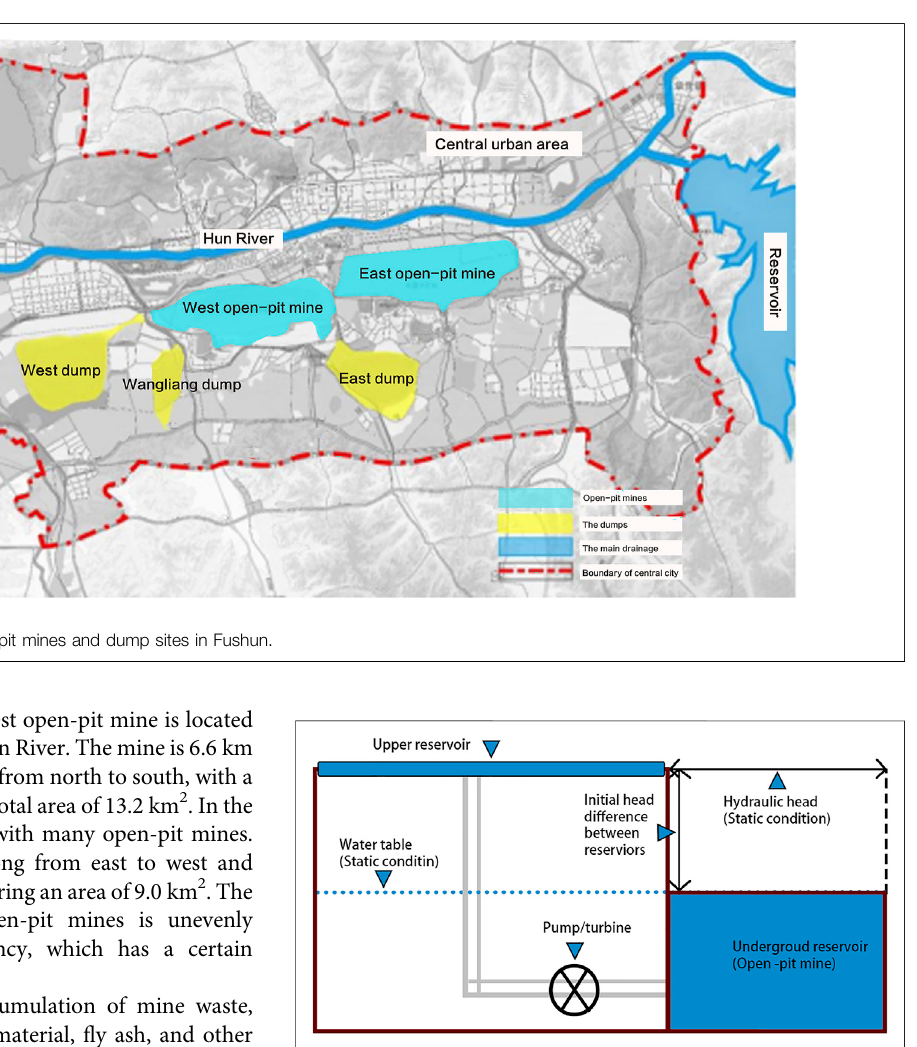
Frontiers in Earth Science |